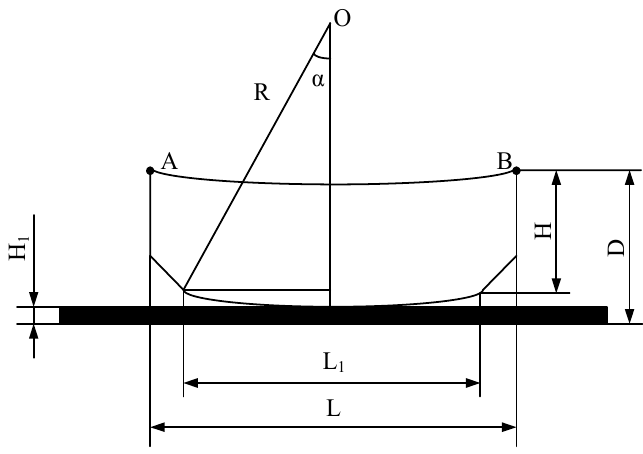
Figure 3. Schematic of warpage calculation.